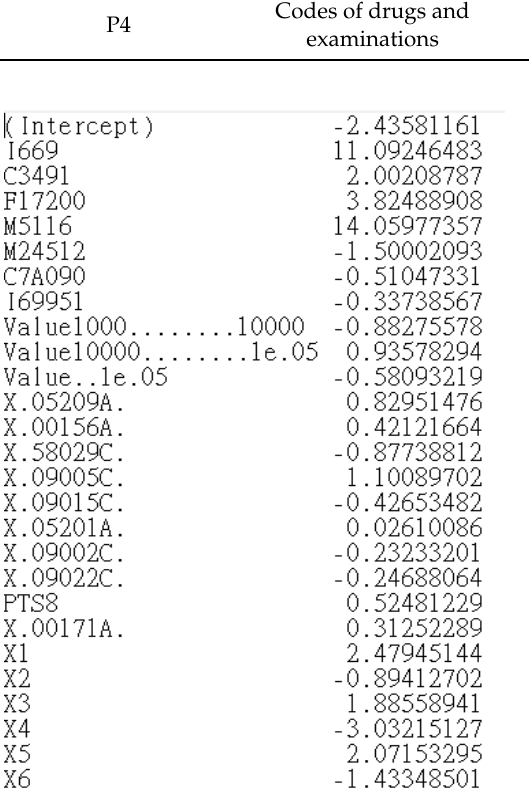
Figure 11. E11 regression coefficients.